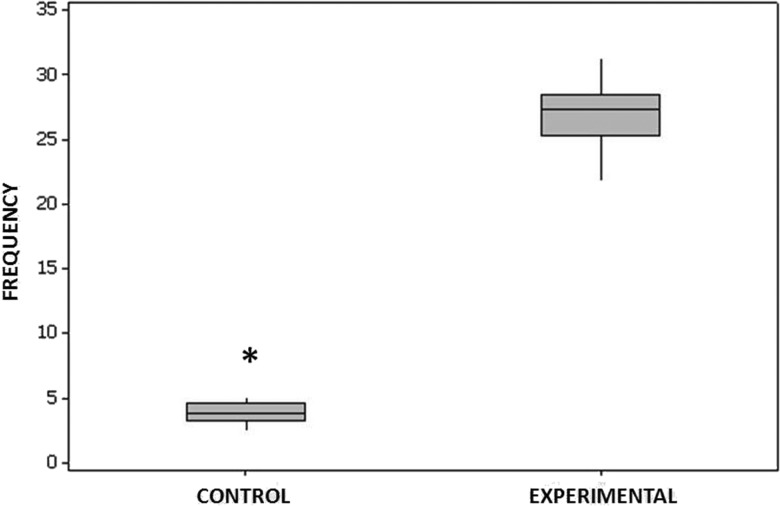
The median of Ki-67-stained nuclei in the vaginal mucosa of animals in the control and tamoxifen groups, as illustrated by the line in boldface.